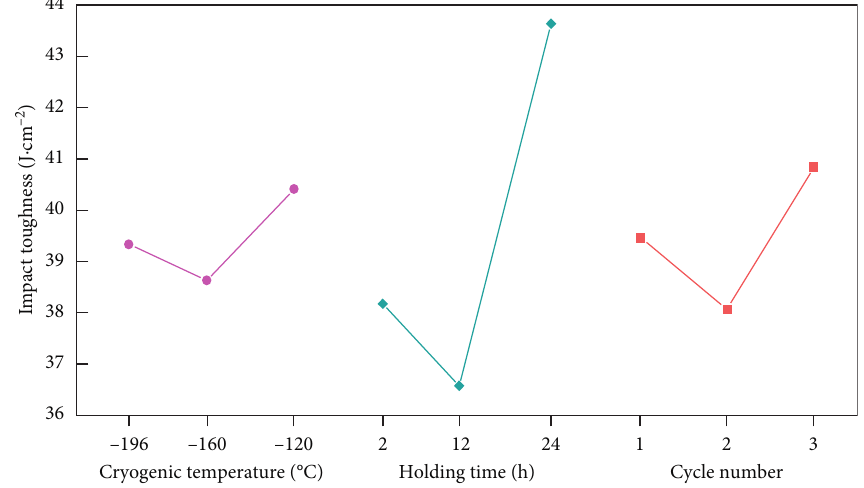
Figure 7: Impact toughness against cryogenic temperature, holding time, and cycles number.